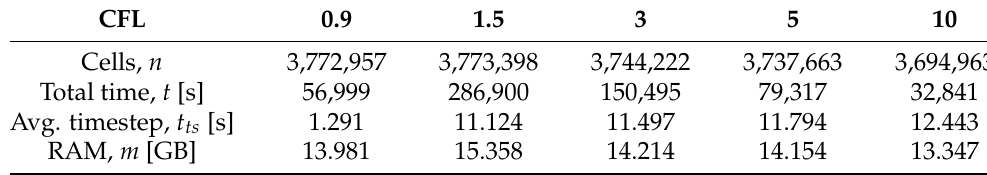
Figure A4. Reynolds stress component u (cid:48) u (cid:48) / U 2 cross at z / D = 1.5, z / D = 3, z / D = 4.5 (top to bottom) where y / D = 0. AMR approach and different turbulence models. Table A3. Performance for different CFL values when using AMR approach with grid size similar to the fine grid. Testing methodology is equal to the one defined for Table A1. Refinement frequency is set to 1000 timesteps. Load balancing is performed when the imbalance reaches